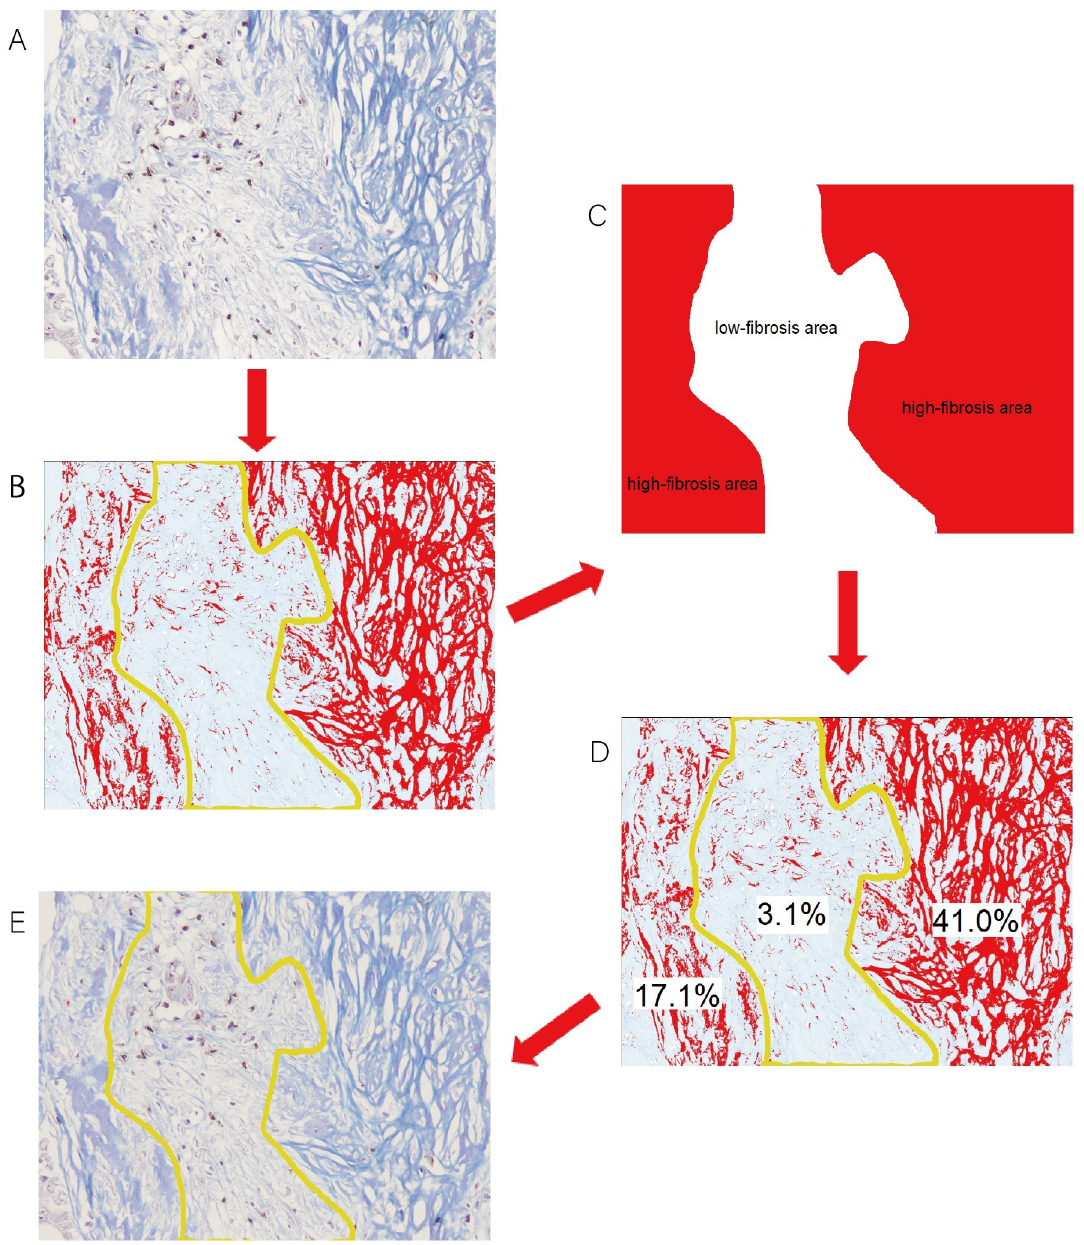
Fig 3. Regarding the evaluation of the distribution of TILs in the high-fibrosis area and that in the low-fibrosis area, the median value of the area ratios of collagen fibers in peritoneal metastases was defined as the cut-off value (15.64%). Areas with an area ratio of collagen fibers greater than the cut-off value ( � 15.64%) were defined as high-fibrosis areas, and those with an area ratio of collagen fibers lower than the cut-off value ( < 15.64%) were defined as low-fibrosis areas. (A) The distribution of tumor-infiltrating lymphocytes in fibrotic areas on double-staining using immunohistochemical staining of anti-CD3 and anti-CD8 and Masson’s trichrome staining at x200 HPF. (B) A post-processed image in which the blue area of collagen fibers changed to a red color and were able to be manually separated into high- and low-fibrosis areas (C) according to the density of collagen fibers. (D) To verify the accuracy of the division, the area ratios of collagen fibers were calculated in each area using the ImageJ software program (area ratios of high-fibrosis areas of a sample image: 41.0% and 17.1%; area ratio of a low-fibrosis area of a sample image: 3.1%) and contrasted with the definitions. If inaccurate division was suspected, the division of the fibrosis area selected by the ImageJ software program was adjusted until the defined conditions were met. (E) The area ratios of the high- and low-fibrosis areas were calculated using the ImageJ software program, and the numbers of tumor-infiltrating lymphocytes in the high- and low-fibrosis areas were counted. The densities of CD3 + /CD8 + TILs in the high- and low-fibrosis areas were then calculated.